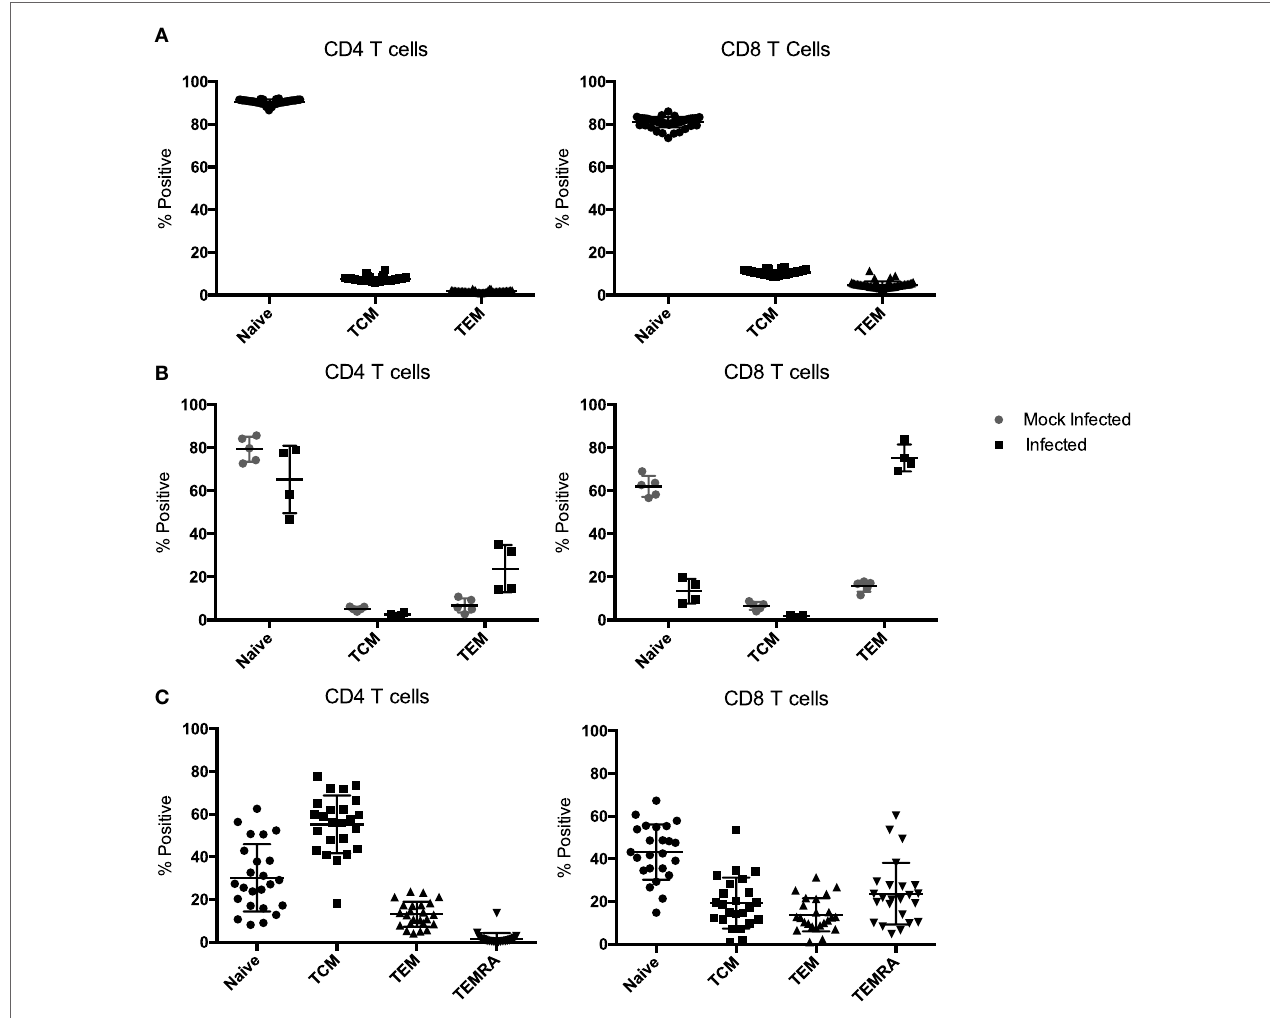
FigUre 2 | Memory subset distribution of CD4 and CD8 T cells in naïve and infected mice. (a) Peripheral blood samples from naive C57BL/6 mice have an almost exclusively naïve immune cell repertoire in both the CD4 and CD8 T cell compartments ( n = 50). (B) Mice infected with polyomavirus (PyV), murine cytomegalovirus (mCMV), and HV68 exhibit a sustained, more diverse immune cell repertoire compared with mock-infected mice up to 70 days post-infection ( n = 5 per group). (c) Memory subset distribution of CD4 and CD8 T cells in adult human subjects is diverse and variable ( n =